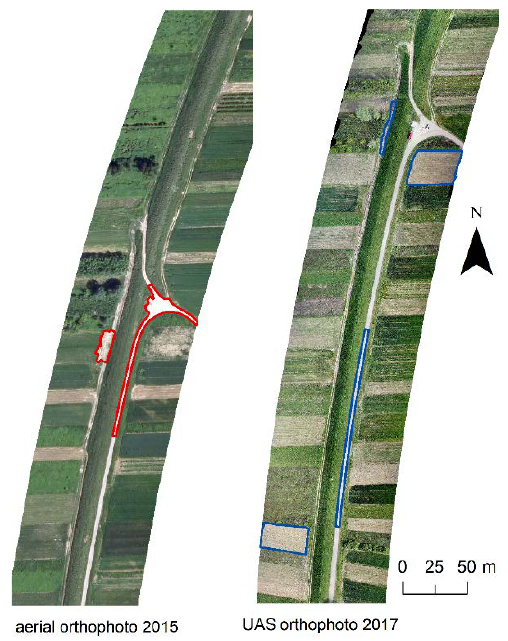
Figure 6. Example of reference polygons used in the best GRVI threshold determination (red polygons—aerial images, blue polygons—UAS images).